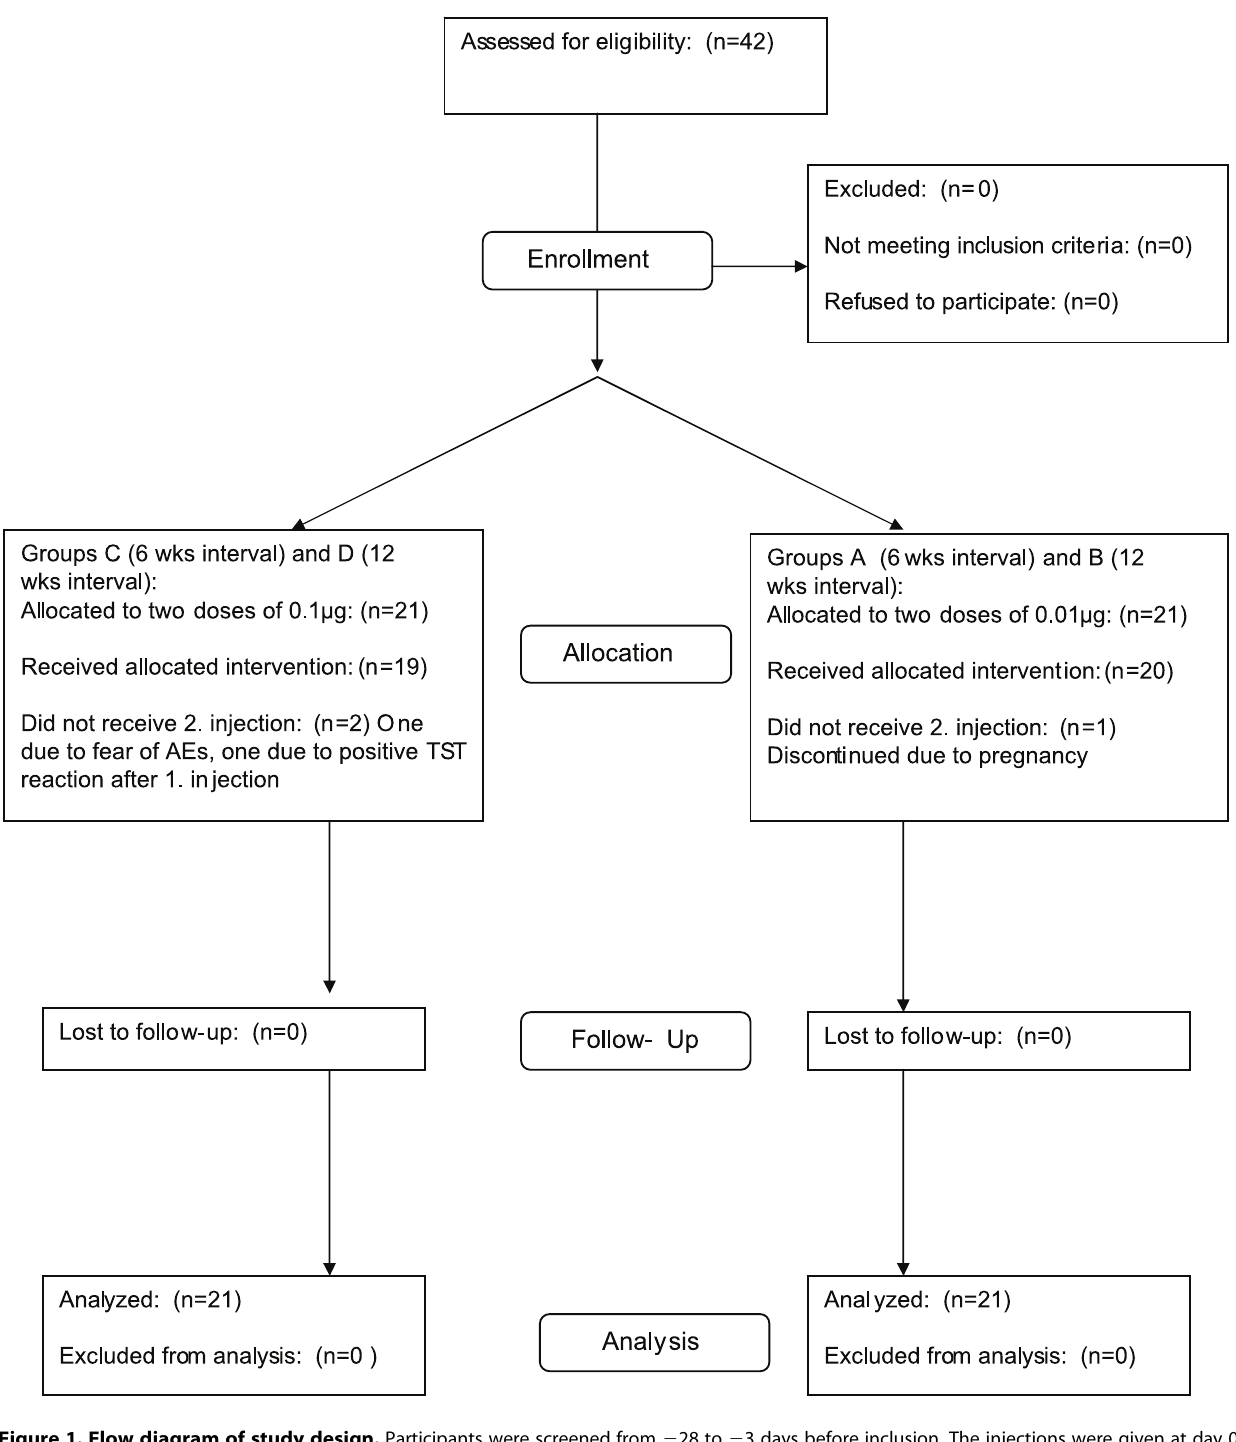
Figure 1. Flow diagram of study design. Participants were screened from 2 28 to 2 3 days before inclusion. The injections were given at day 0 and day 42 or on day 0 and day 84. Group A and B received 0.01 m g of the investigational skin test antigen. Group C and D received 0.1 m g. All volunteers completed a final follow-up visit 28 days after the last injection.